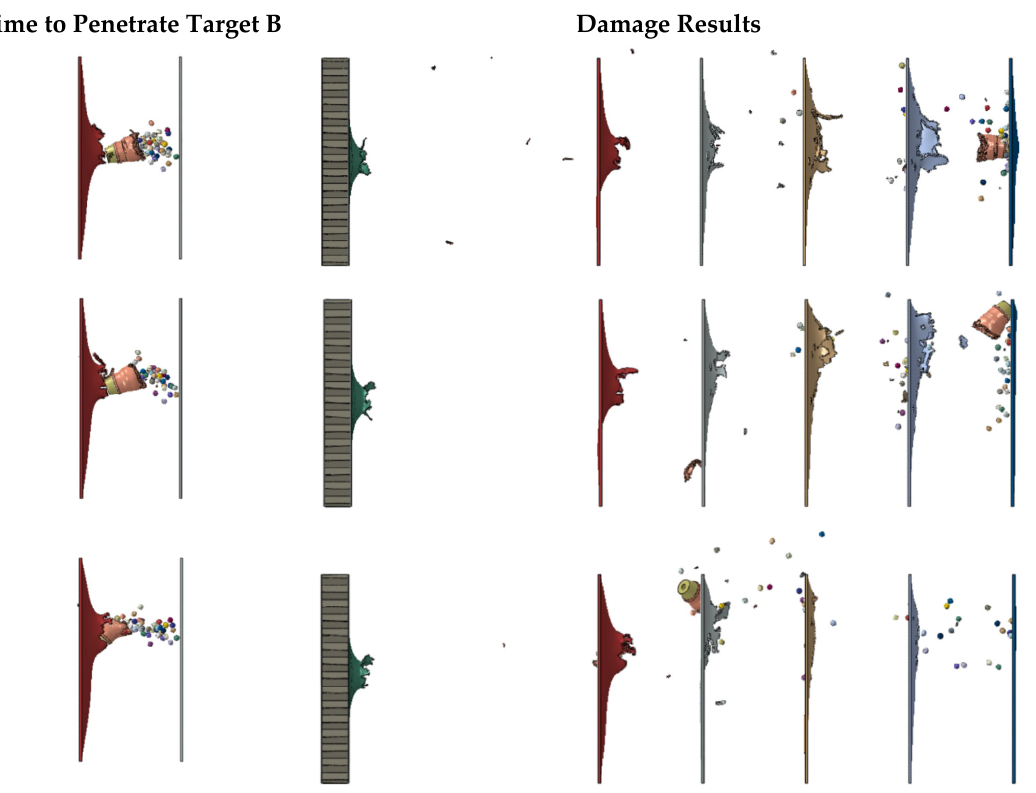
Figure 11. Damage effect of the kinetic projectile impact under different incident angles.